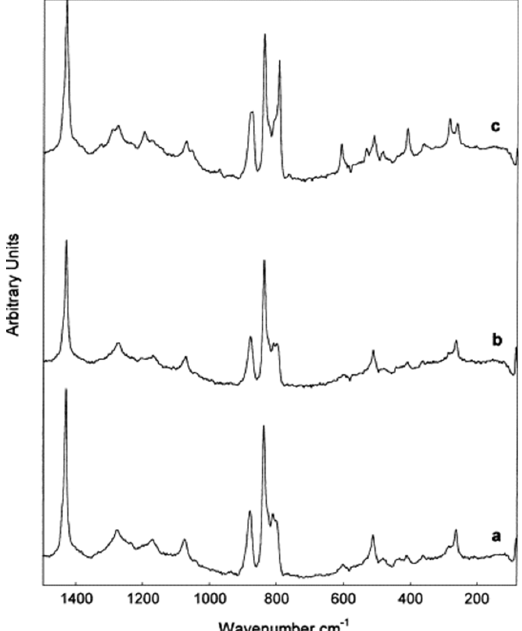
Figure 23. Raman spectroscopy of PVDF membrane using different solvents: ( a ) DMF; ( b ) NMP; ( c ) triethyl phosphate (TEP) [101].